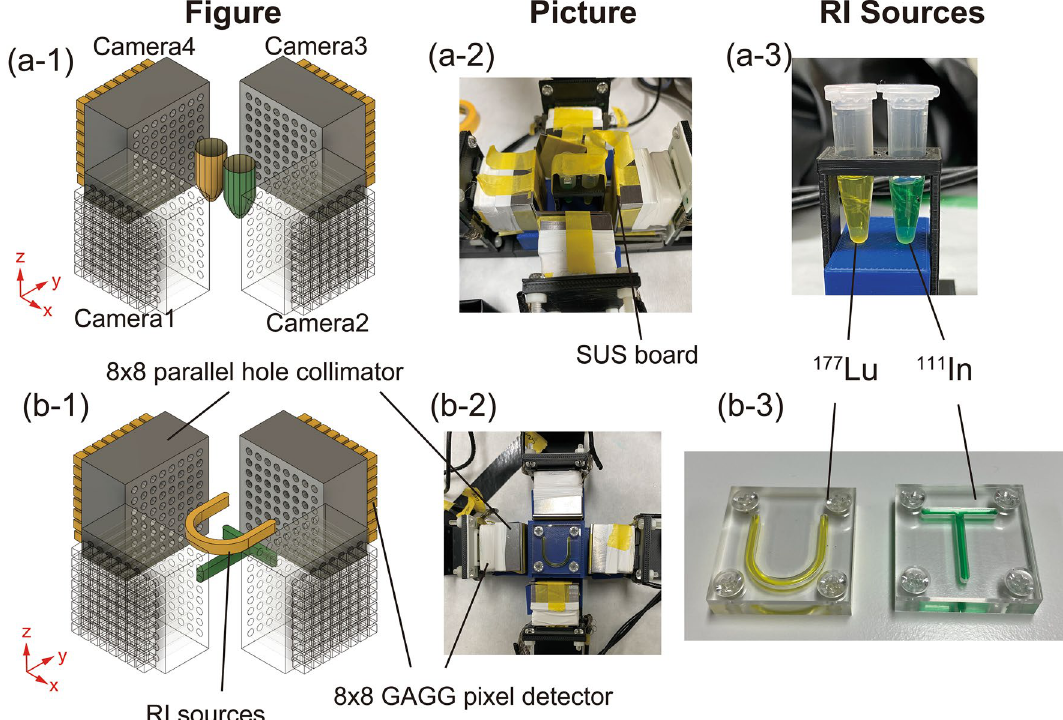
Figure 5. Experimental setup. ( a-1 – a-3 ) Experimental setup with the RI sources of 111 In and 177 Lu in 0.5 mL microtubes (( a-1 ) experimental setup, ( a-2 ) experiment, and ( a-3 ) RI sources in the microtubes). ( b-1 – b-3 ) Experimental setup with the RI sources of 111 In and 177 Lu in the acrylic cases of alphabetical letters “U” and “T” (( b-1 ) experiment setup, ( b-2 ) experiment, and ( b-3 ) RI sources in the acrylic cases of alphabetical letters “U” and “T”). Figure ( a-1 , b-2 ) were created using the software (Autodesk Fusion 360, v.2.0.9719, https:// www. autod esk. com).